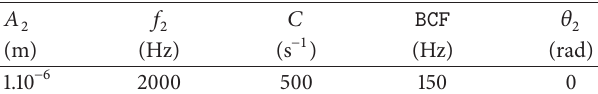
Table 1: Parameters related to the simulated test signal 𝑦 1 (𝑡) . Table 2: Parameters related to the simulated test signal 𝑦 2 (𝑡)